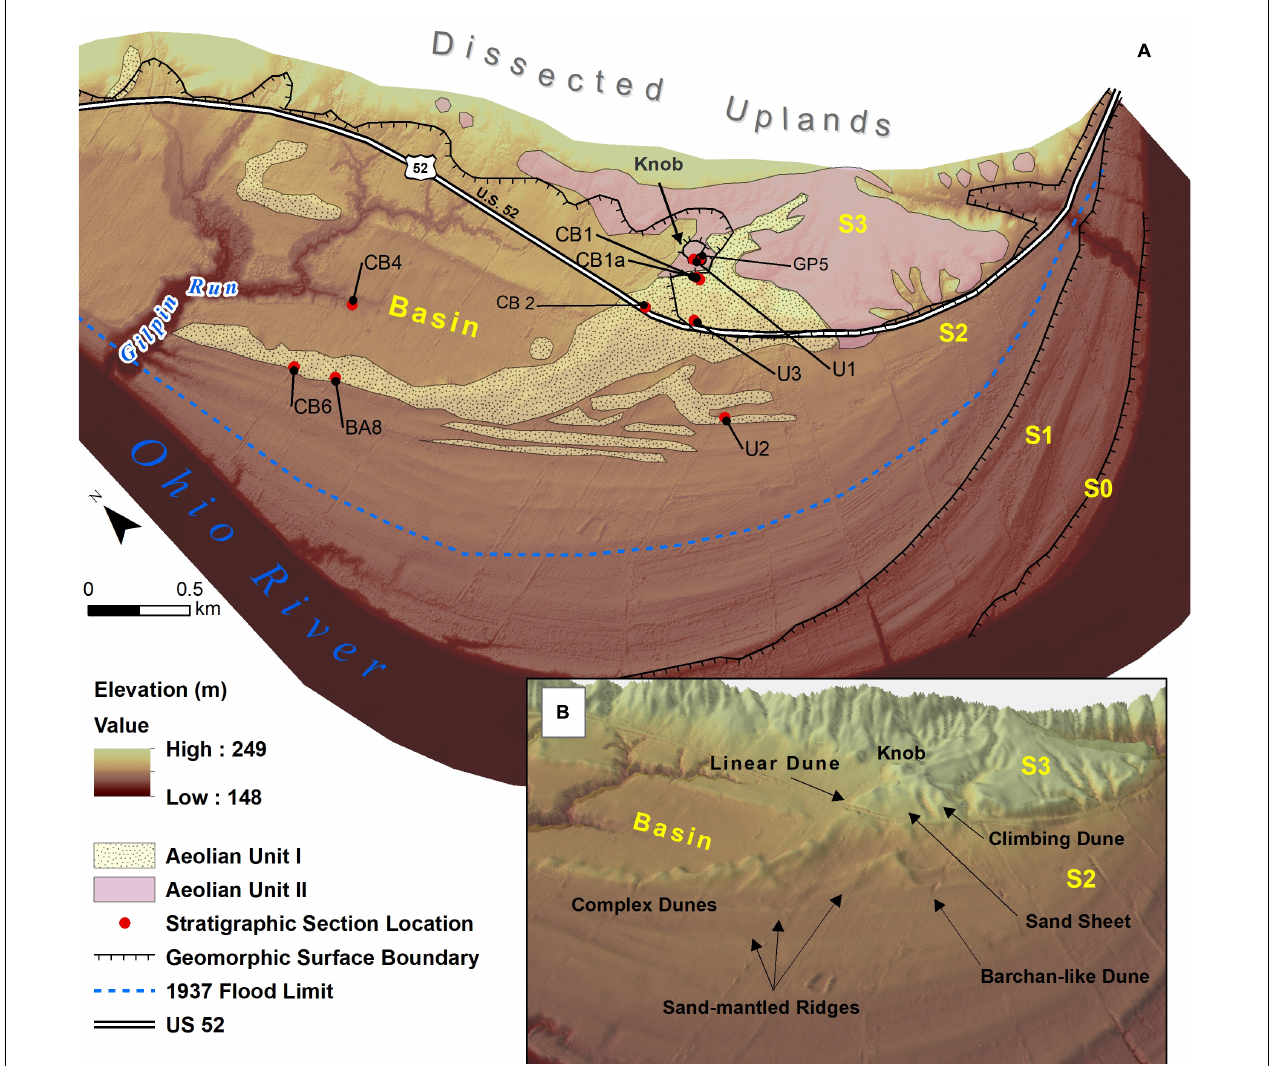
FIGURE 3 | (A) Sandy Springs LiDAR image showing distribution of described sections, geomorphic surfaces (S0-S3) and landforms, 1937 flood limit, and surficial distribution of aeolian units I and II. The distribution of aeolian units is based on current study results and previous research (Morris and Pierce, 1967). (B) Oblique ArcScene 3D representation of a close-up section of LiDAR image (A) at 3x vertical exaggeration showing dune types, interdunal sand sheet, and sand-mantled